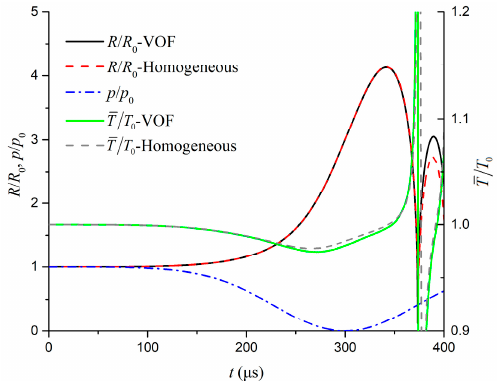
Figure 2. Bubble radius and average temperature of case D predicted by the VOF method and homogeneous model. The dash dot line denotes the negative pressure pulse.